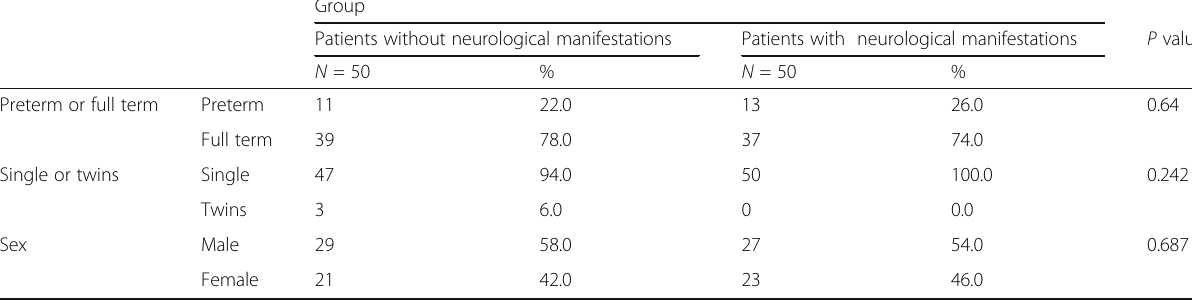
Table 3 Demographic data of all studied groups of neonates ( n = 100) Group Patients without neurological manifestations Patients with neurological manifestations